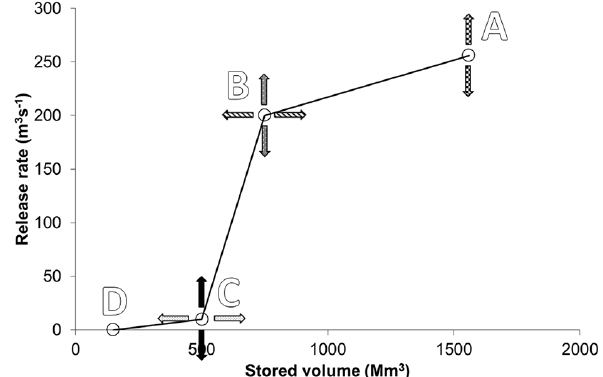
Figure 2. Reservoir release rule (hedging) curves as represented by the IRAS-2010 model. Each patterned pair of opposing arrows rep- resents an optimisation decision variable. Point D is the dead stor- age of the reservoir. Point A represents the controlled release when the reservoir is full. B and C points can be varied in two dimensions for hedging. In total, five decision variables define each reservoir’s release